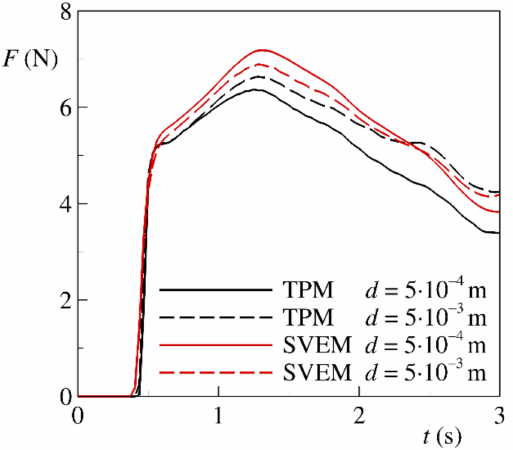
Figure 2. Temporal evolution of the impact forces for the two considered sand diameters. The Saint– Venant–Exner model (SVEM) vs. the two-phase model